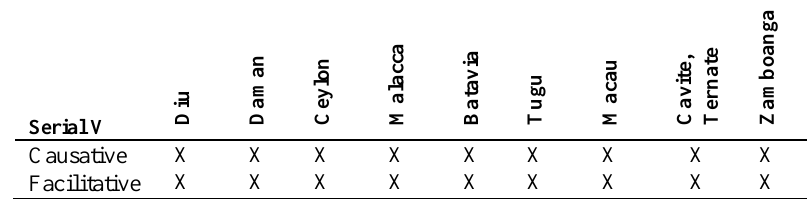
Table I: Causative verb serialization in Asian CP (and Philippine